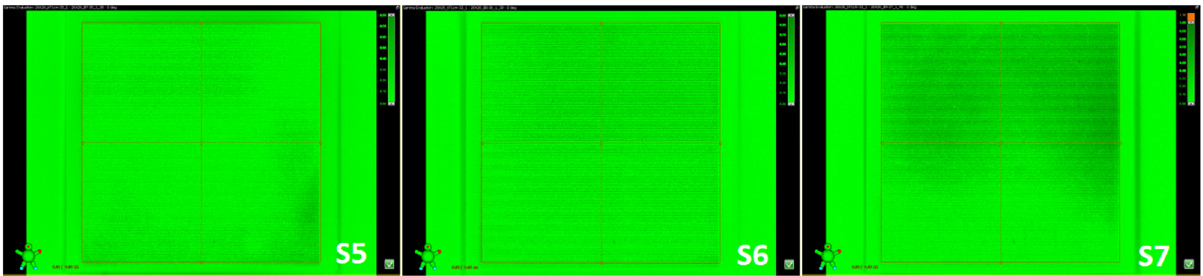
Figure 6: Blended view of gamma analysis results of the 1 cm thick bolus samples and R1 for 0.5%/0.5 mm and higher criteria ( from left to right S5, S6 and S7, respectively )